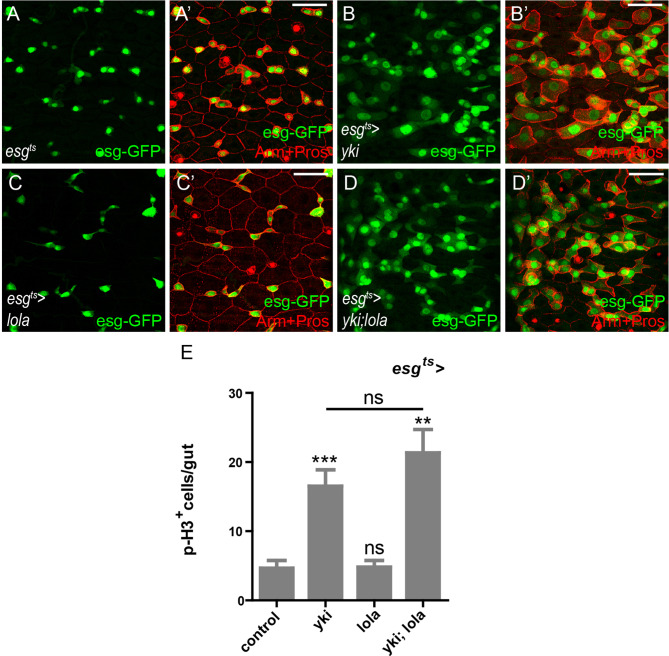
Lola and Yki regulate the midgut homeostasis in different means.(A-F’) Representative images of Drosophila adult midguts of esgts (A-A’), esgts >yki (B-B’), esgts >lola (C-C’), and esgts >yki; lola (D-D’) immunostained with Arm and Pros (red). ISCs and EBs are marked with esg-GFP (green). Merged images are shown in A’, B’, C’, and D’ (green and red). (E) Quantifications of the p-H3+ cell number in adult midguts with the indicated genotypes in A-D (n = 6, 6, 7, 9). Note that co-expression of lola and yki does not suppress the increase in the p-H3+ cell number induced by yki overexpression (ns p>0.05). Scale bars: 30 μm. Data are shown as mean ± SEM. ns p>0.05, **p<0.01, and ***p<0.001 by Student’s T-test. At least 10 midguts were dissected for each genotype. Confocal images were taken from the basal layer of the midgut where ISCs can be clearly visualized. Single layer image is shown.